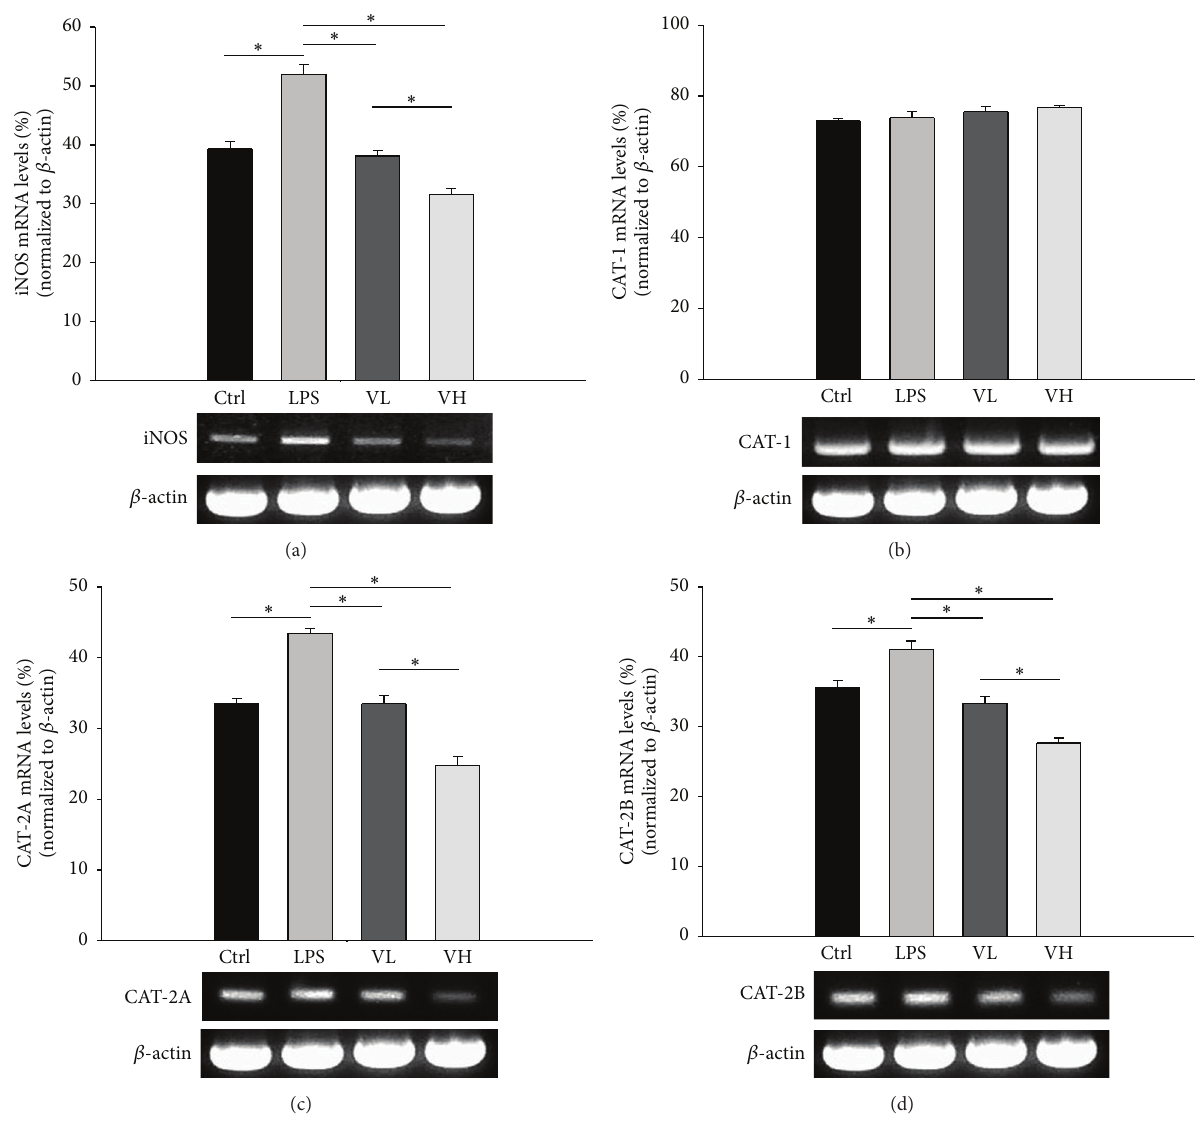
Figure 6: CAT and iNOS mRNA expression in RAW 264.7 cells. The RNA was isolated under control conditions (Ctrl), from rats treated with LPS alone (LPS), and from rats pretreated with 10nM bortezomib (VL) or 25 nM bortezomib (VH). The symbol “ ∗ ” indicates statistical